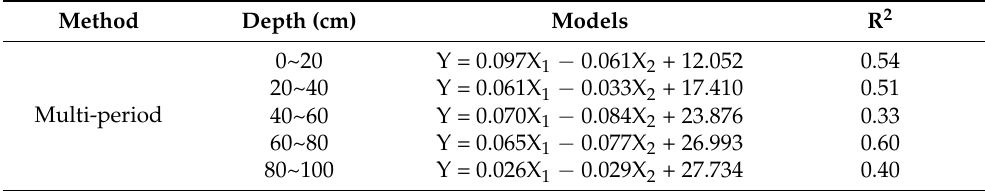
Table 5. Predicted relationships of soil-water content at different depths for the whole period.